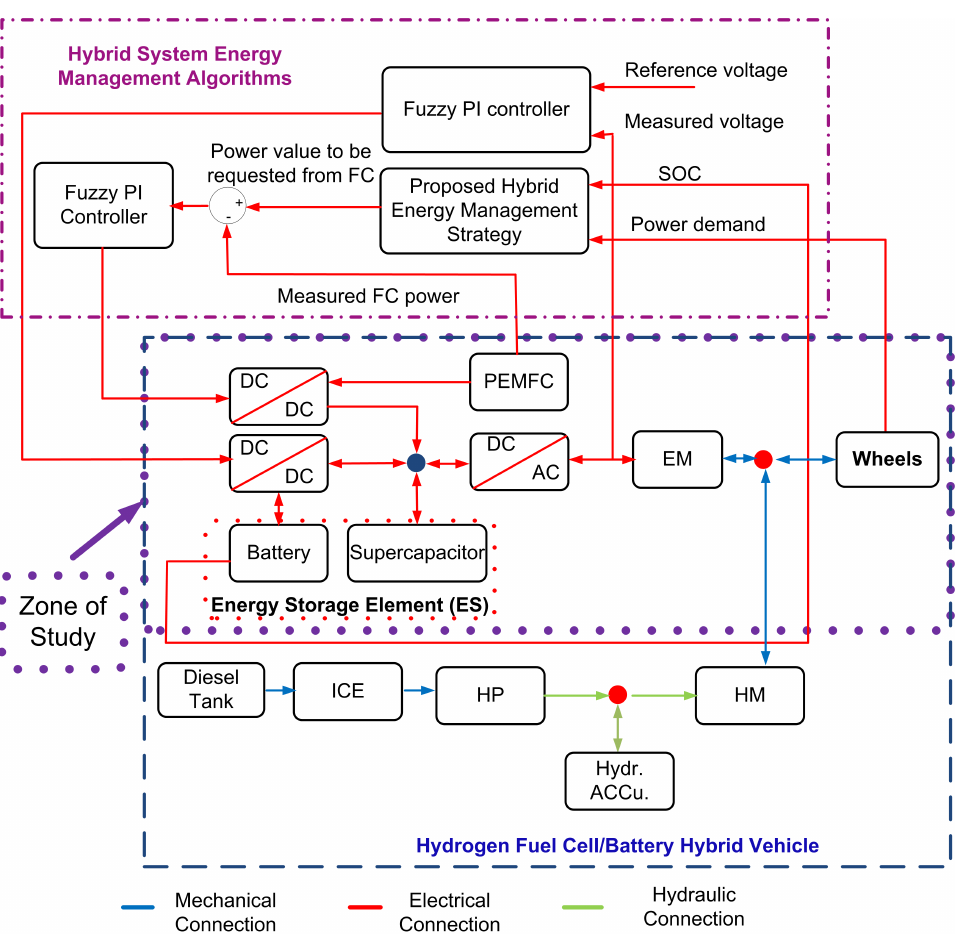
Figure 1. Hybrid system configuration and the powertrain power flows (ICE: Internal Combustion Engine, HP: Hydraulic Pump, HM: Hydraulic Motor, EM: Electric